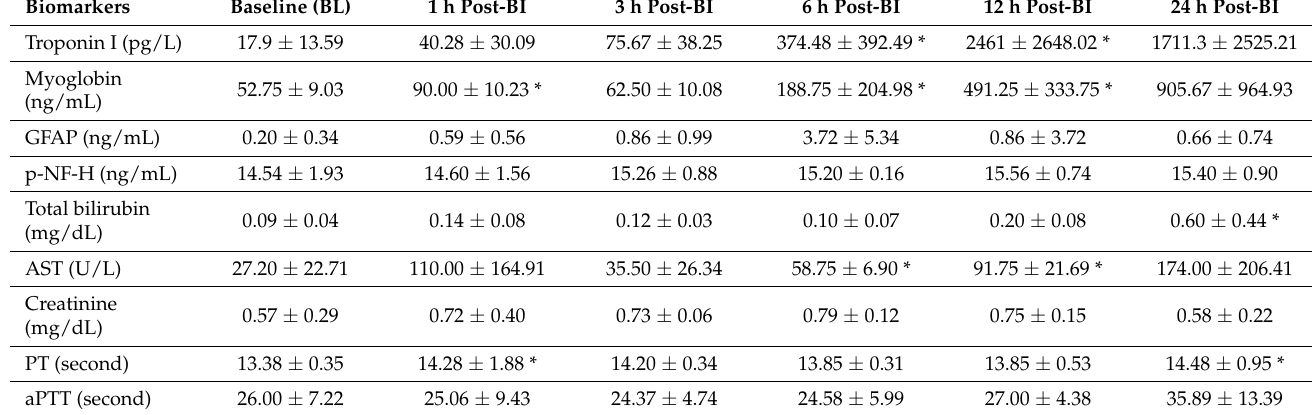
Table 3. Circulating levels of organ injury biomarkers in a porcine BI+HS model.